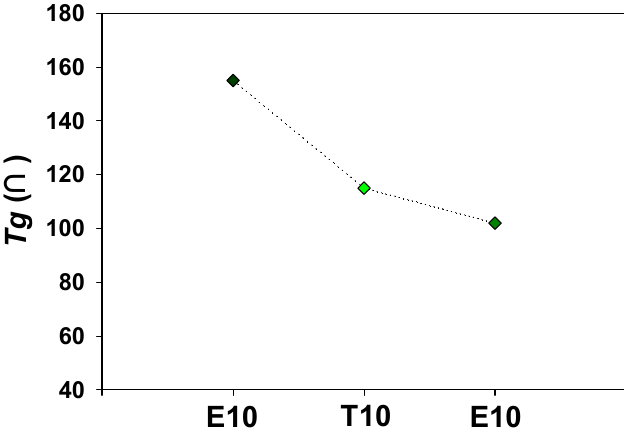
Figure 8. E ff ect of the crosslinker on glass transition temperatures of crosslinked Figure 8. Effect of the crosslinker on glass transition temperatures of crosslinked PAMPS.